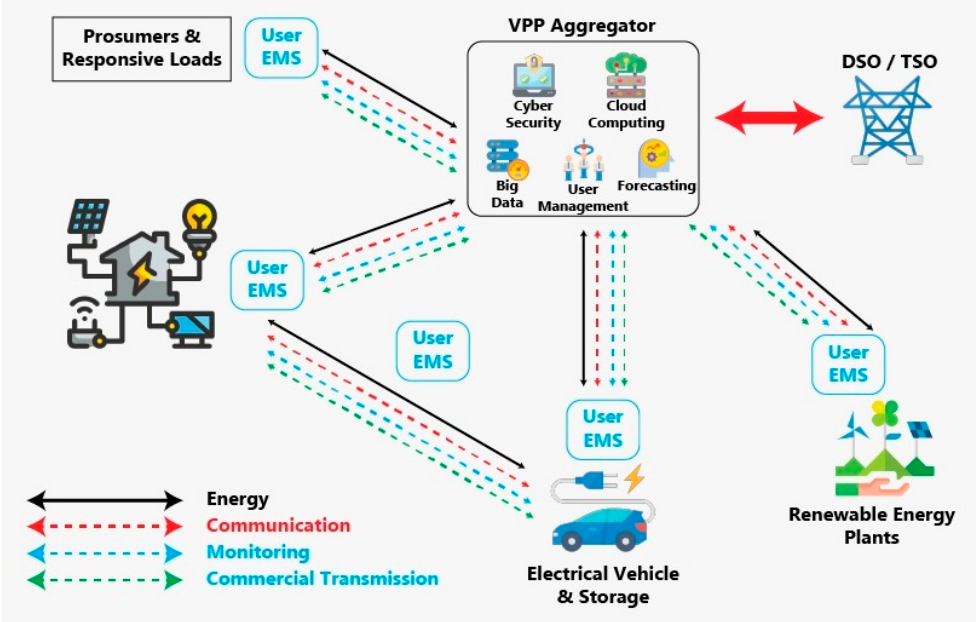
Figure 1. Schematic diagram of the virtual power plant (VPP).